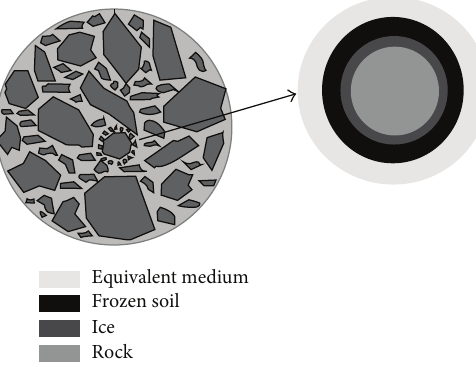
Figure 6: Three-layer embedded model and microstructure sec- tional drawing of frozen soil-rock